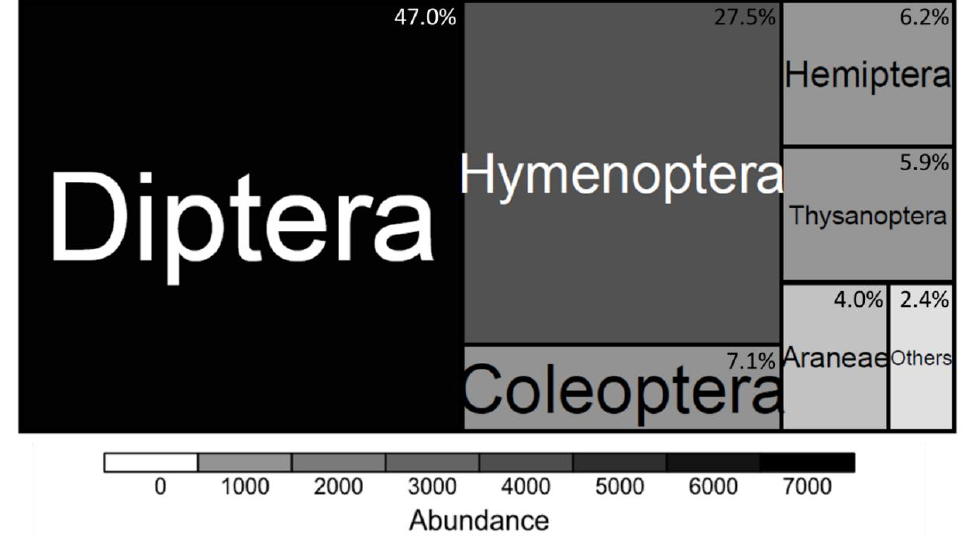
Figure 2. The abundance of arthropod orders caught with pitfall and pan traps during a 72-h sampling in 36 vegetable fields of Tamale, Northern Region, Ghana, in August